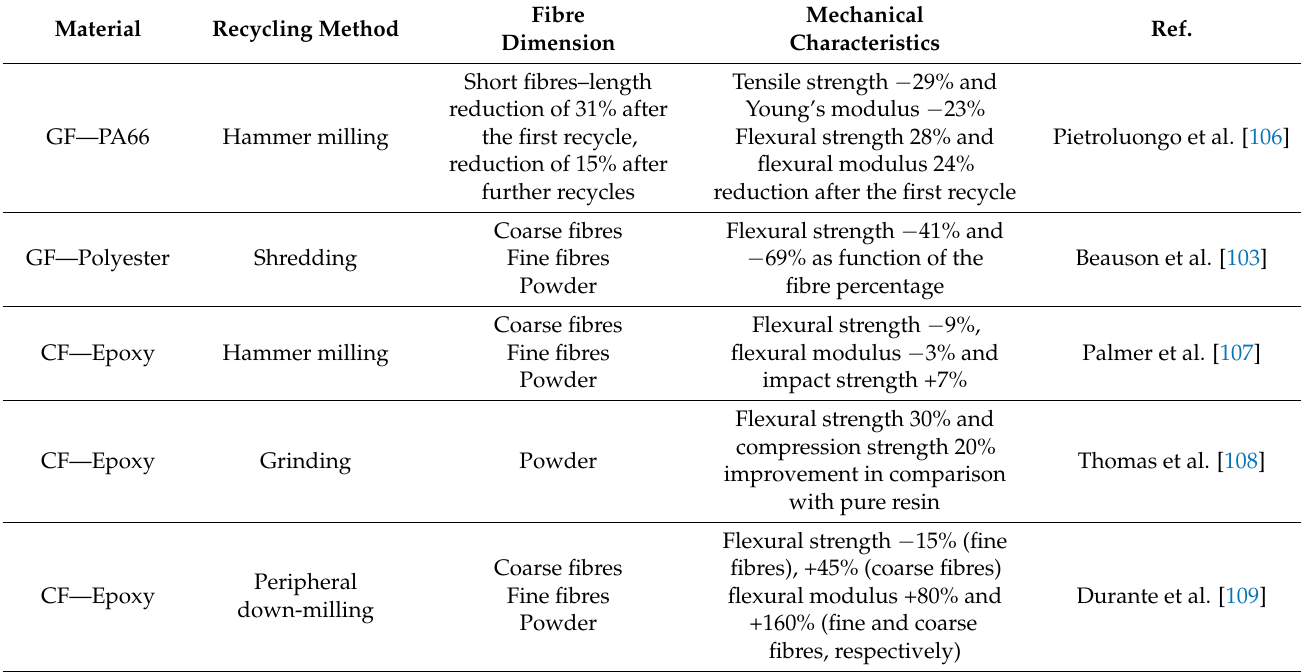
Table 6. Main results deriving from mechanical recycling